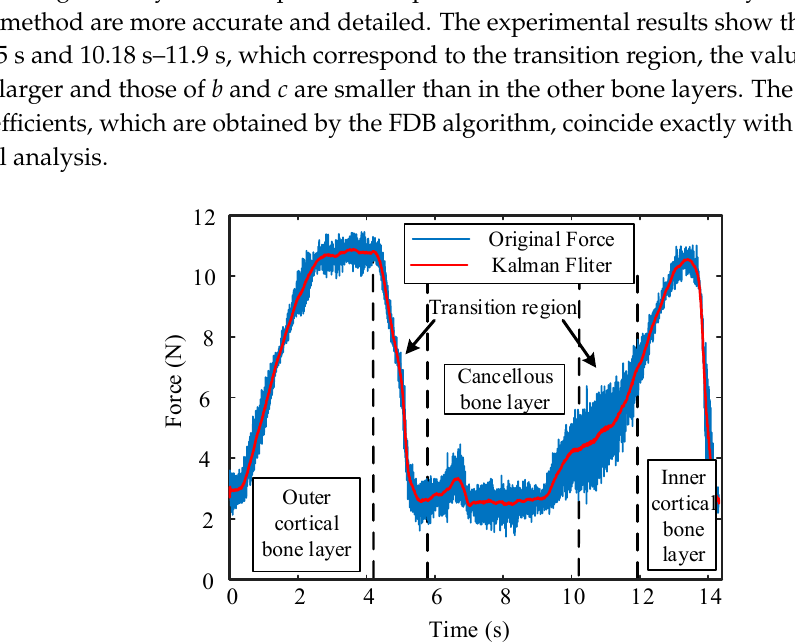
Figure 14. Force signal for bone layer identification. The blue line represents the original data and the red line is the signal after processing by the Kalman filter, which is smoother. Different bone layers for different times are listed in the figure. Table 3. Data of the three methods used for the bone layer identification.